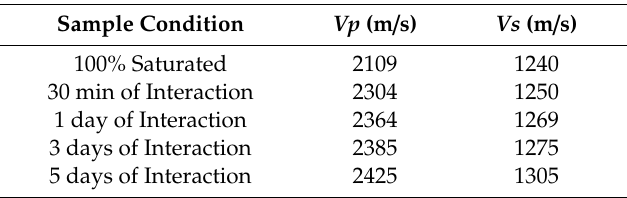
Table 4. The sonic data recorded at each